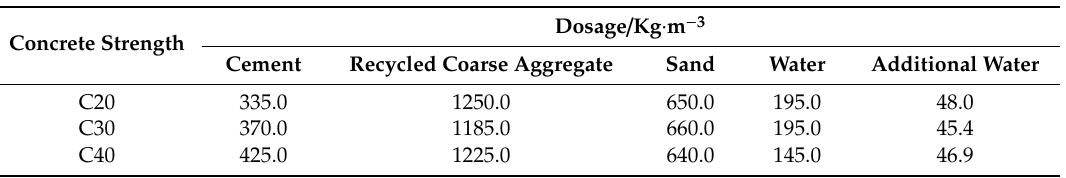
Table 4. Mix design of recycled aggregate concrete